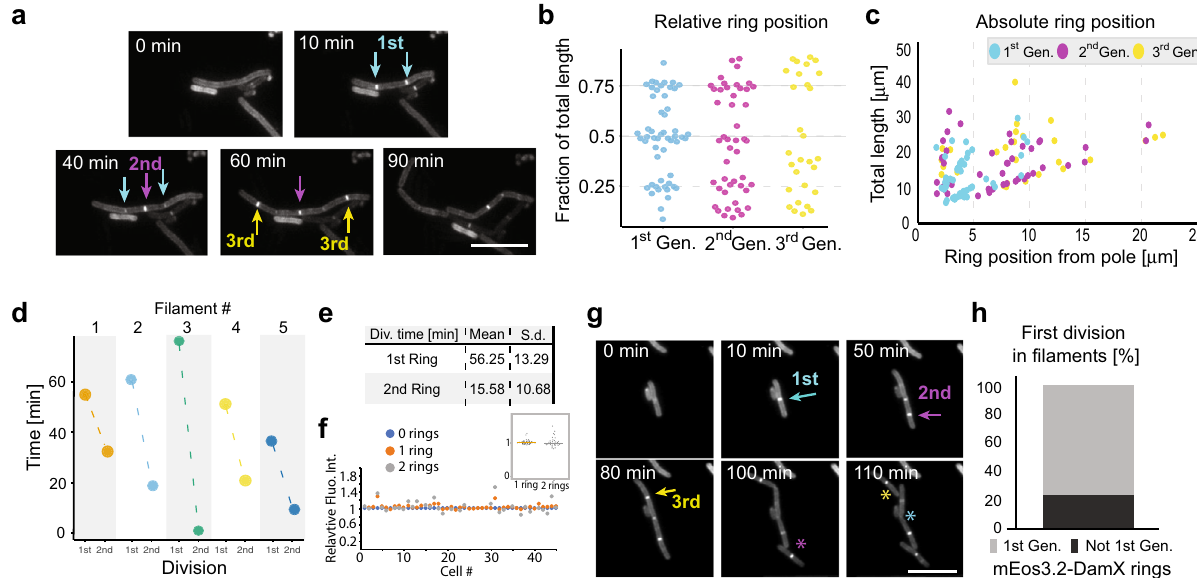
Fig. 6 mEos3.2-DamX localization and dynamics in fi laments. a Time-lapse images of fi laments expressing mEos3.2-DamX (Supplementary movie SM14). Formation of mEos3.2-DamX rings was followed over time in fi laments where no rings were observed in the fi rst image. Cyan arrows show fi rst generation, magenta arrow second generation and fi nally yellow arrows indicate the third generation division rings. b Relative de novo positioning of mEos3.2-DamX division rings in fi laments. Most rings assembled at locations close to 1/4, 1/2 or 3/4 of the total fi lament length. Colour coding follows that in a . Gen. = Generation. n = 134. c The distance of mEos3.2-DamX rings in μ m from one of the cell poles. d Plot shows the time from fi rst mEos3.2- DamX ring formation to the fi rst division (1st), and the time from the fi rst division to the second (2nd, Δ t = t 2 − t 1 ) for fi ve randomly picked fi laments. e Summary showing average times of fi rst and second division based on mEos3.2-DamX ring formation and constriction. f Total cellular mEos3.2-DamX fl uorescence intensity did not change with formation of division rings. Blue dots represent total integrated fl uorescence normalized to fi lament area one frame before formation of the fi rst ring, orange dots represent integrated fl uorescence when one ring had formed, grey dots represent integrated fl uorescence when two rings had formed. f inset, Relative mean cellular fl uorescence with one ring = 1.02 ± 0.07 ( n = 45), relative mean cellular fl uorescence with two rings = 1.03 ± 0.15 ( n = 32). Values represent mean ± SD. g A shorter fi lament from a time-lapse movie indicating that the second generation of mEos3.2-DamX ring (magenta, formed at t = 50) constricted and pinched off prior to the fi rst ring formed (cyan, formed at t = 10 min). First image showing a full division is at t = 100 min, at the place where the second mEos3.2-DamX ring was formed (indicated by a magenta asterisk). Division of the fi rst mEos3.2-DamX ring is indicated by cyan asterisk. A third-generation mEos3.2-DamX ring is indicated by the yellow arrow (with division indicated by yellow asterisk). Scale bar 10 μ m. h In all, 23% of the second generation mEos3.2-DamX rings formed in fi laments pinched off before the fi